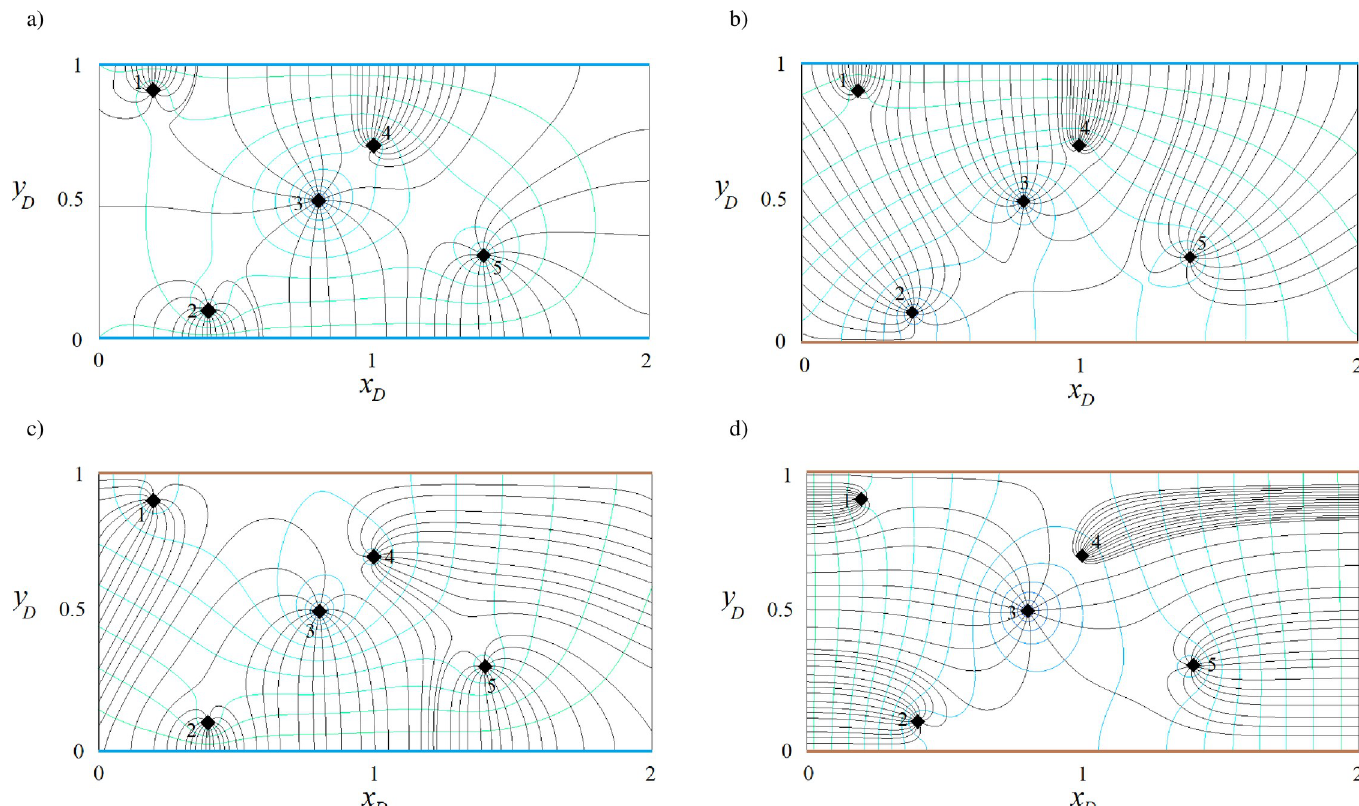
Fig 9. Capture zones of Fig 8 generated by numerical models.